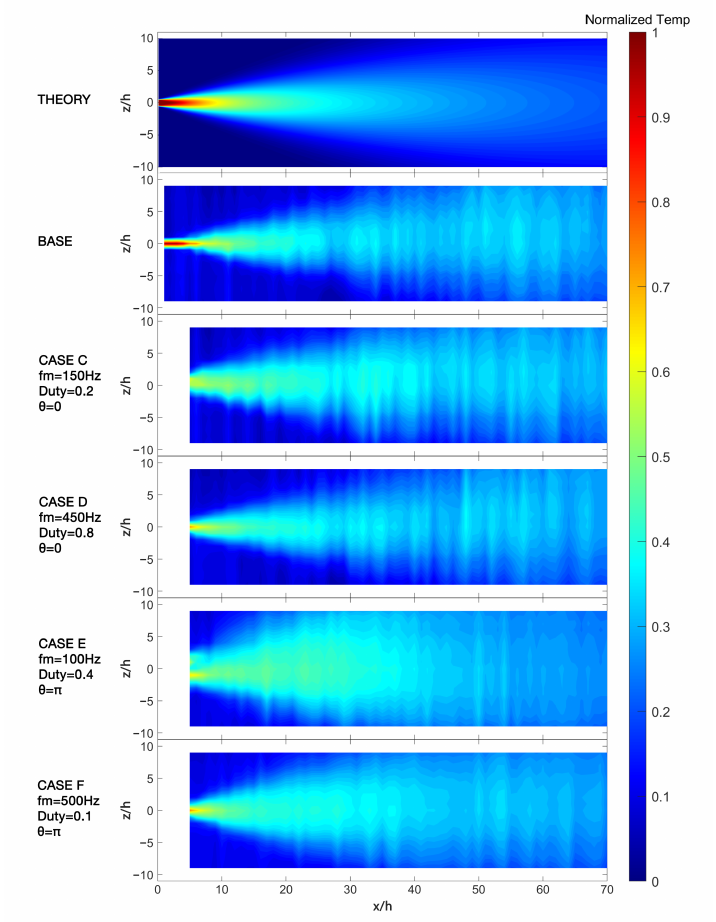
Figure 21. Normalized temperature contour plot on xz cut section where y / h = 0 for different